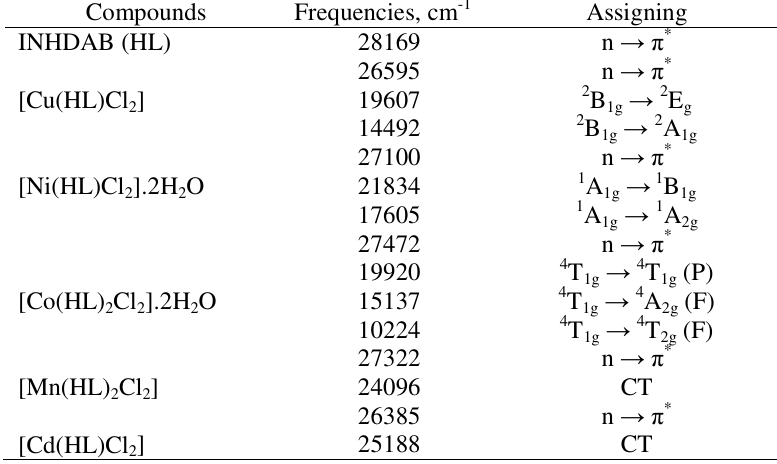
Table 3. Reflection spectra for the ligand and